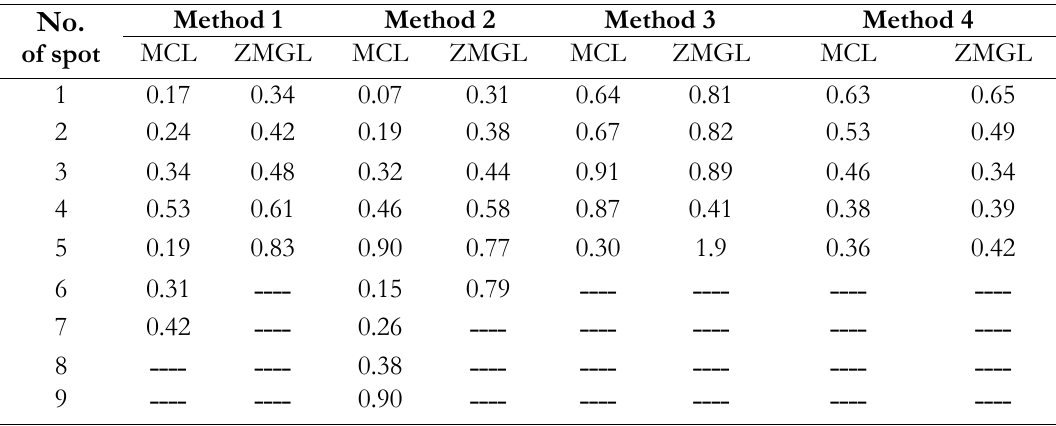
Table V. Gymnemic acid Rf value estimation by TLC determination using different methods No.